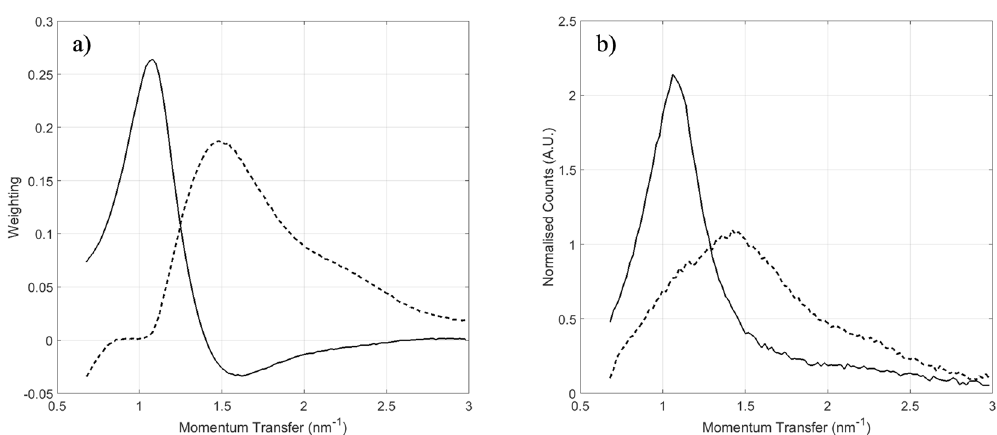
Figure 4. ( a ) Loading plots for PC1 (solid) and PC2 (dashed) and ( b ) X-ray diffraction (XRD) spectra having maximum PC1 score (solid) and maximum PC2 score